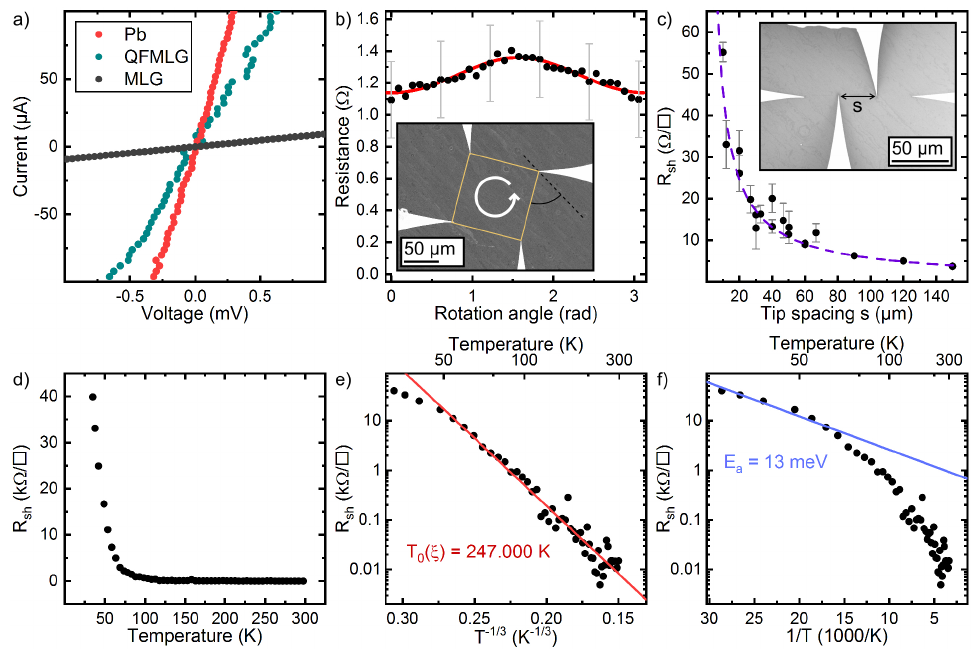
Figure 5. ( a ) IV-curves on Pb-intercalated graphene ( T = 300 K). For reference, the IV-curves of QFMLG and MLG are shown as well ( s = 30 µm). ( b ) Rotational square measurement for a fixed tip distance of 100 µm. The inset shows a SEM image of the tip assembly ( T = 300 K). ( c ) Sheet resistance R sh as a function of the tip spacing s . The inset shows the collinear probe geometry ( T = 300 K). ( d ) Sheet resistance as a function of temperature for a fixed collinear probe configuration ( s = 30 µm). ( e ) Anderson plot of the data shown in panel ( d ) covering the temperature range down to 60 K. ( f ) Arrhenius analysis of the transport data shown in panel ( d ). The low temperature regime reveals an activation energy of 13